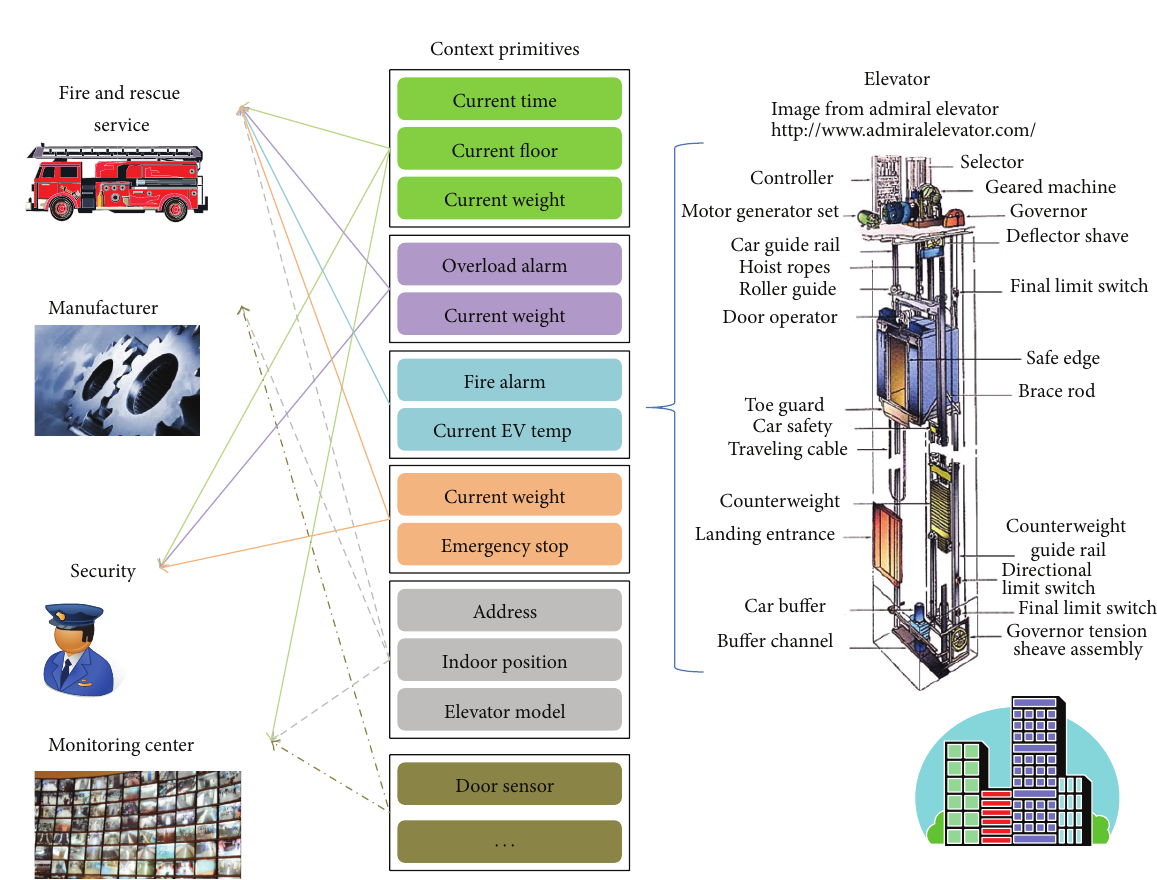
Figure 2: Example of context